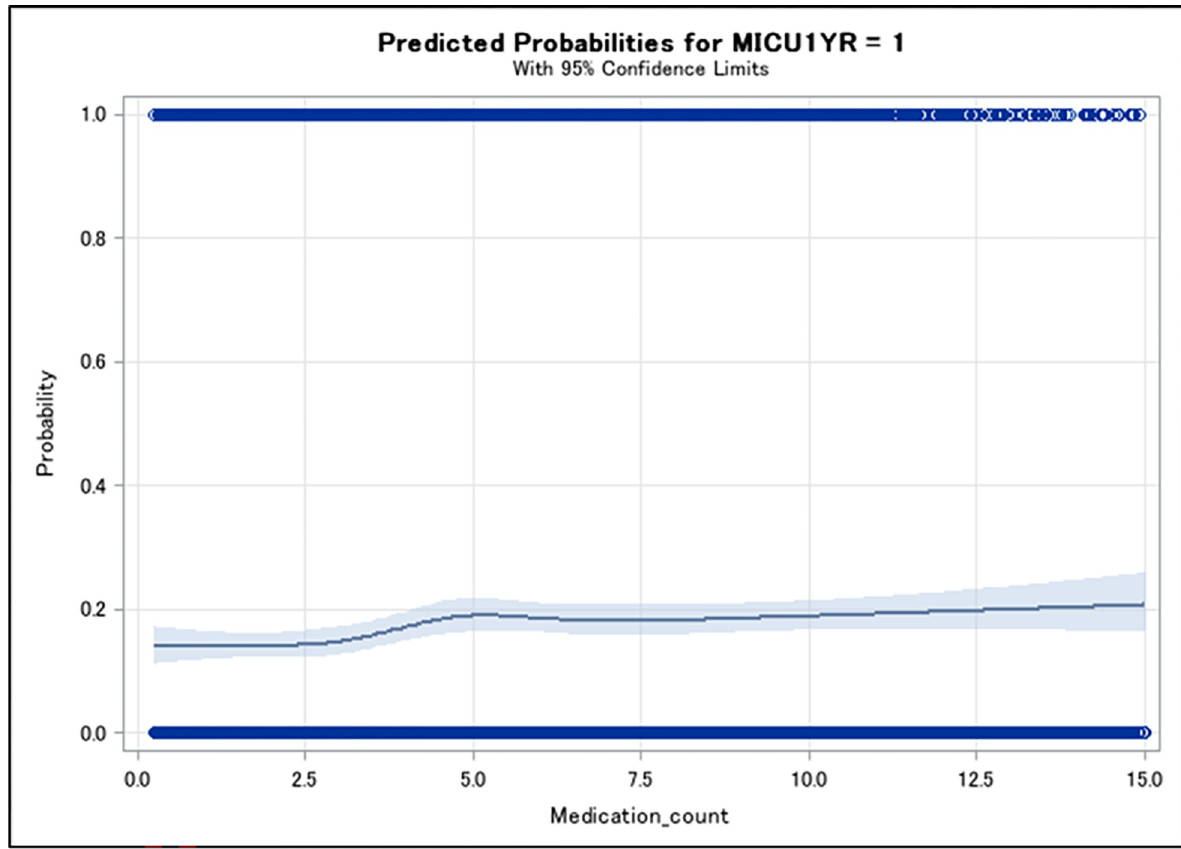
Fig 2. Restricted cubic spline predicted probability of 1-year MICU admission vs non-ARV medication count. https://doi.org/10.1371/journal.pone.0276769.g002 Table 5. Cox regression models looking at increments of medication count and 10-year all-cause mortality. Unadjusted, n = 9898 Adjusted, n = 9898 PWH, n =